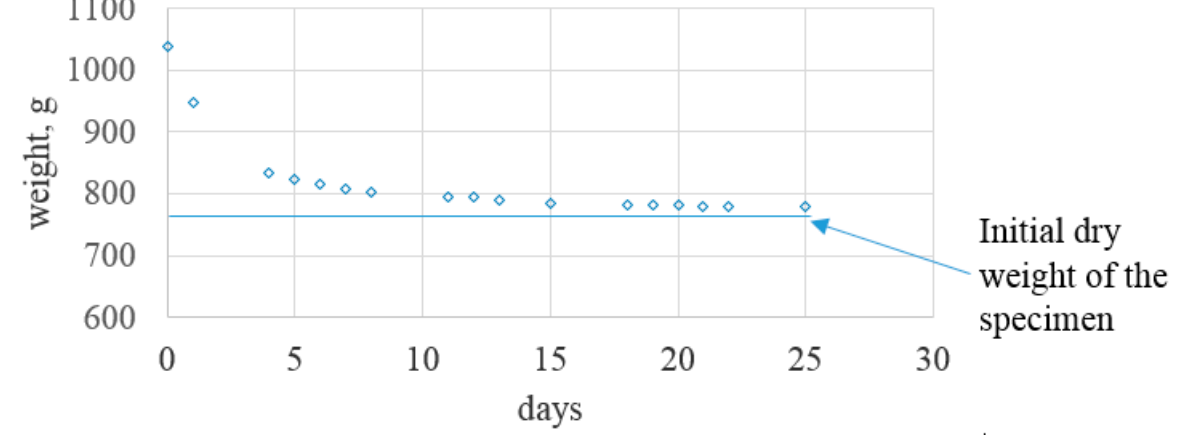
Figure 7. Loss of weight for wet specimens under conditioning (temperature 23 ± 2 °C, humidity 60 ± 5%), in days.